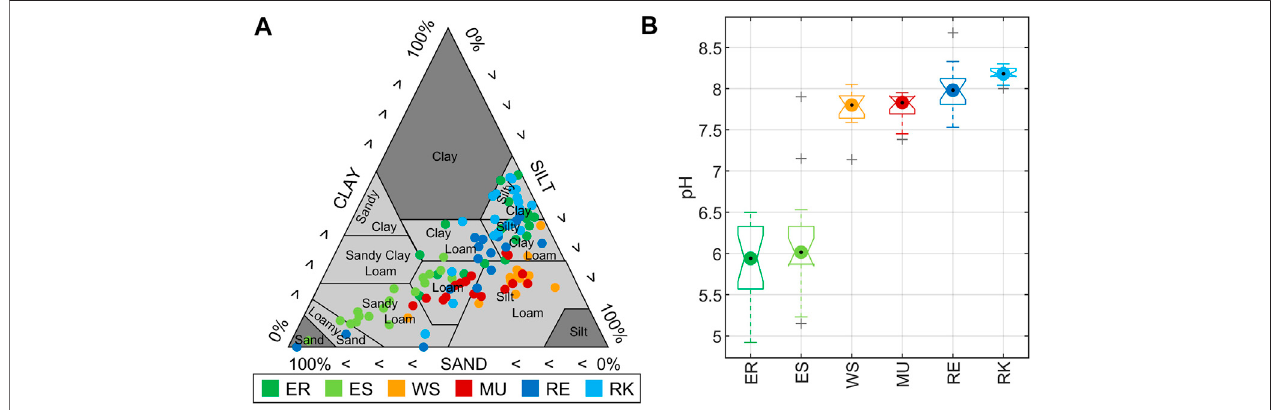
FIGURE3 | (A) Soil texture distribution of samples from the study areas: Elbe_R (ER), Elbe_S (ES), Weser_S (WS), Main_U (MU), Rhine_E (RE), Rhine_K (RK). All in the soil texture triangle de fi ned by the United States Department of Agriculture (USDA). (B) Comparison of average soil pH between the study areas. Box lines show upper and lower quartiles. Whiskers extend to the 95th and fi fth percentiles.